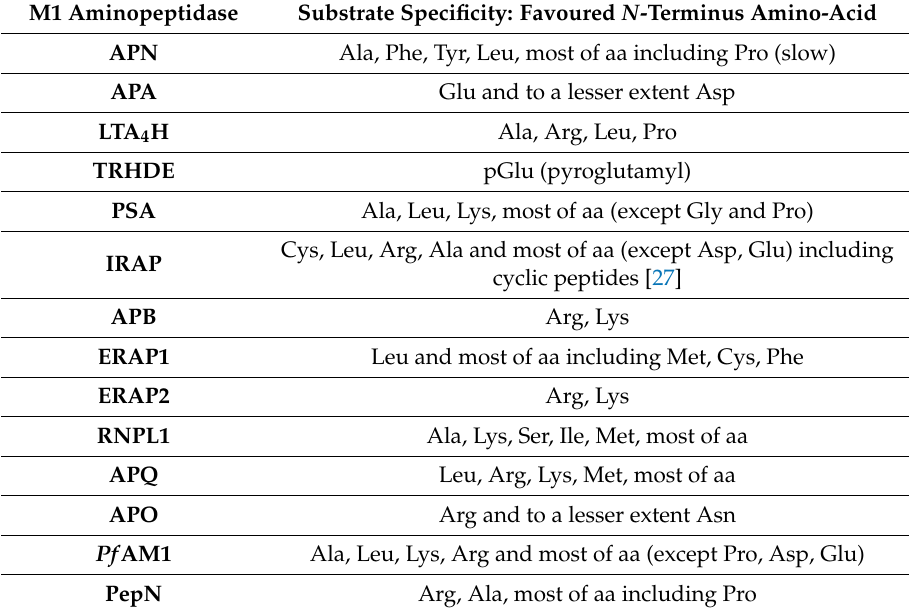
Table 2. Substrate specificity: preferred N -terminus amino-acid for a selection of M1 aminopeptidases [1]. M1 Aminopeptidase Substrate Specificity: Favoured N -Terminus Amino-Acid APN Ala, Phe, Tyr, Leu, most of aa including Pro (slow) APA Glu and to a lesser extent Asp LTA 4 H Ala, Arg, Leu, Pro TRHDE pGlu (pyroglutamyl) PSA Ala, Leu, Lys, most of aa (except Gly and Pro) Cys, Leu, Arg, Ala and most of aa (except Asp, Glu) including IRAP cyclic peptides [27] APB Arg, Lys ERAP1 Leu and most of aa including Met, Cys, Phe ERAP2 Arg, Lys RNPL1 Ala, Lys, Ser, Ile, Met, most of aa APQ Leu, Arg, Lys, Met, most of aa Arg and to a lesser extent Asn Ala, Leu, Lys, Arg and most of aa (except Pro, Asp, Glu) PepN Arg, Ala, most of aa including